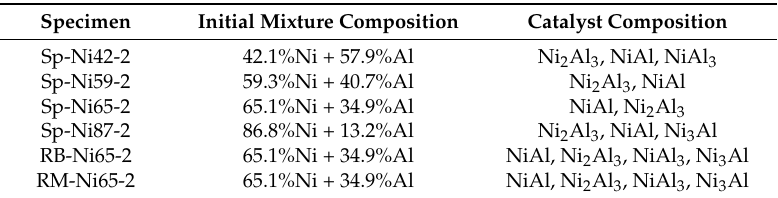
Table 2. Initial powder mixture composition and the main catalytically active alloys in the coatings produced by CAFSY on various substrates using only 2 gun passes.